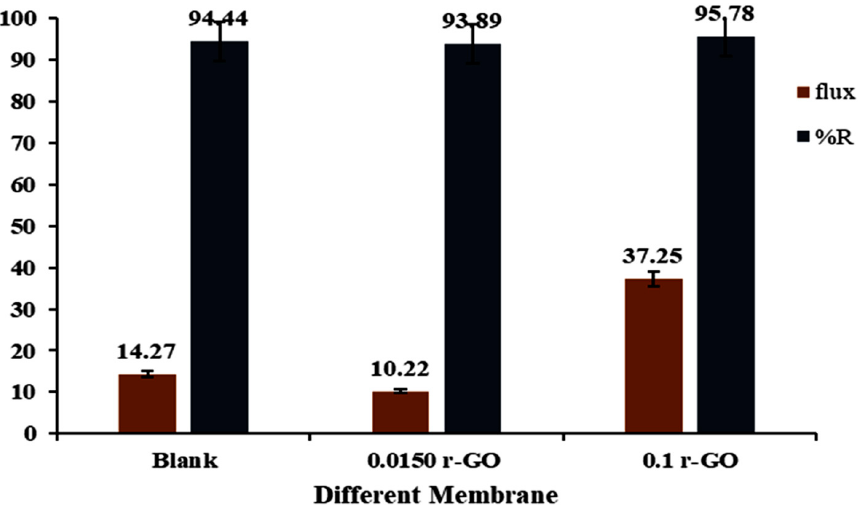
Figure 13. Water flux and rejection of iron after filtration using different contents of reduced graphene oxide nanomaterials in the membrane filter.